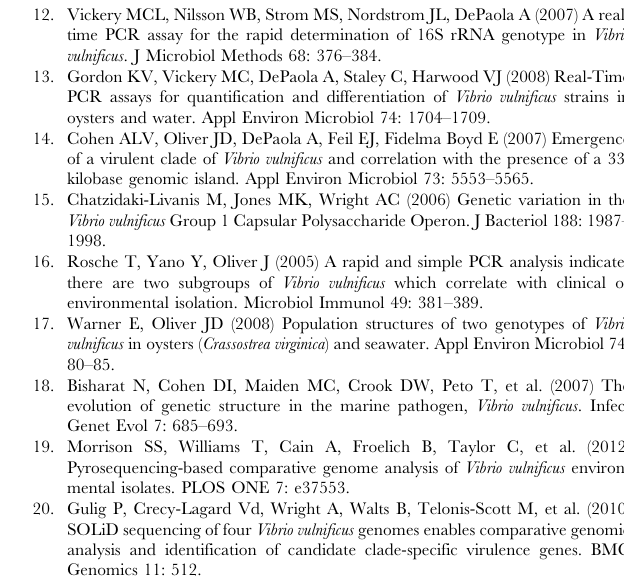
Figure S1 MLST majority-rule consensus tree based on the genealogies inferred by Clonal Frame with the null hypothesis of recombination ( r = 0). Figure S2 Genetic representation of events indicated in Fig. 2 nodes A and B. Columns correspond to six MLST gene fragments. Black crosses indicate inferred substitutions with the intensity proportional to its probability and the height of the red lines represents the inferred probability for recombination on a scale from 0 to 1 ( Y -axis). Figure S3 Arylsulfatase A unrooted neighbor joining tree; Kimura’s 2-parameter distance, 1000 bootstraps replicates.